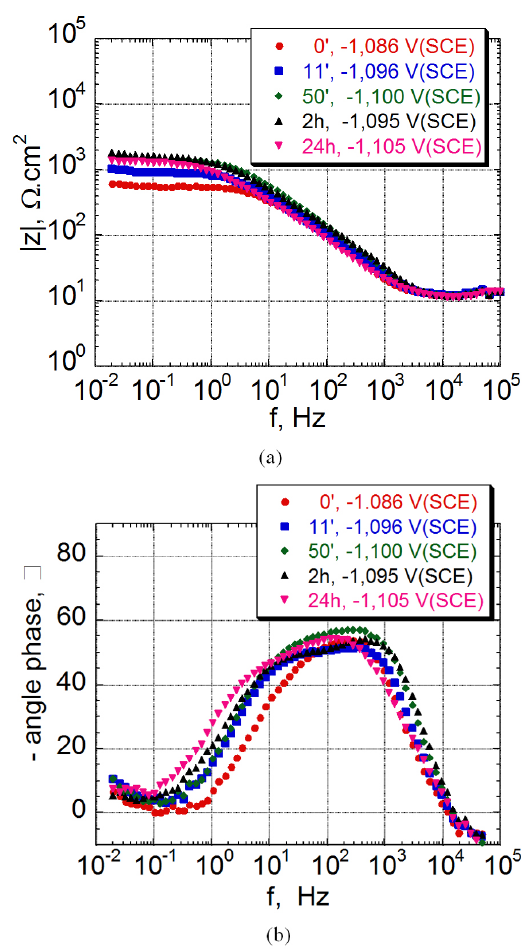
Figure 3. (a) Bode magnitude and (b) phase angle plots as a function of immersion time in aerated 0.3 mol.L –1 Na Cr 3+ chromated electrogalvanised steel coating – sample protected with treatment